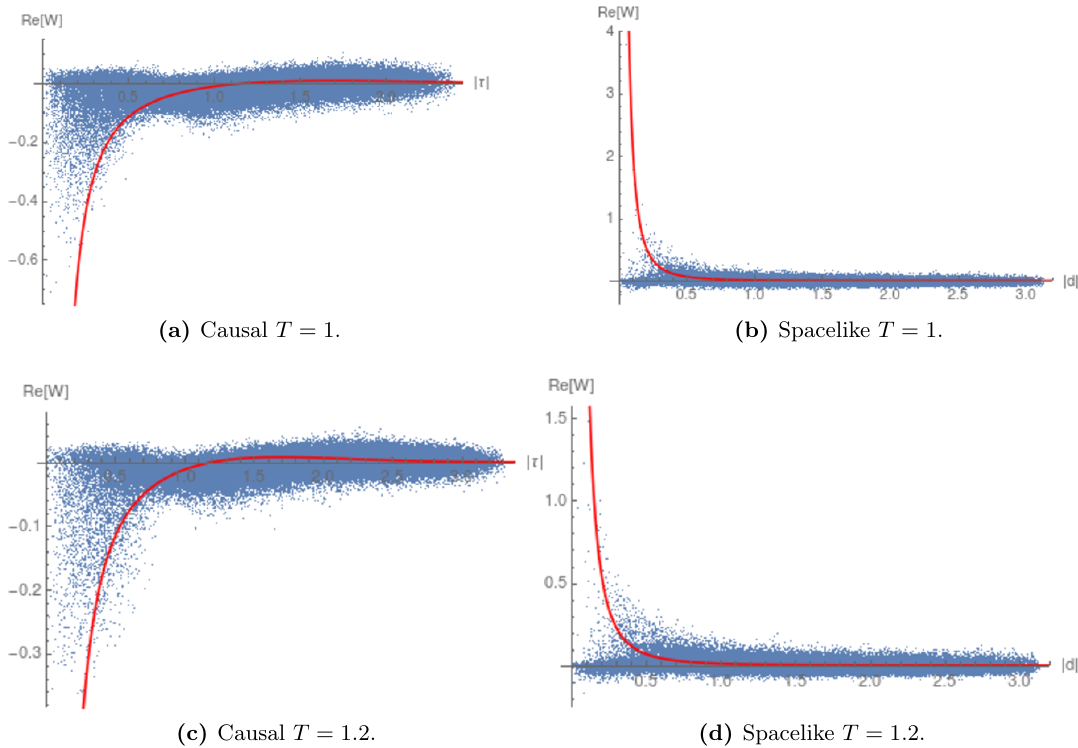
Figure 22. m = 2 : 3 ; N = 32000, in 4d de Sitter. Re[ W of 100000 randomly selected pairs. The red curve shows the Euclidean two-point function W E from